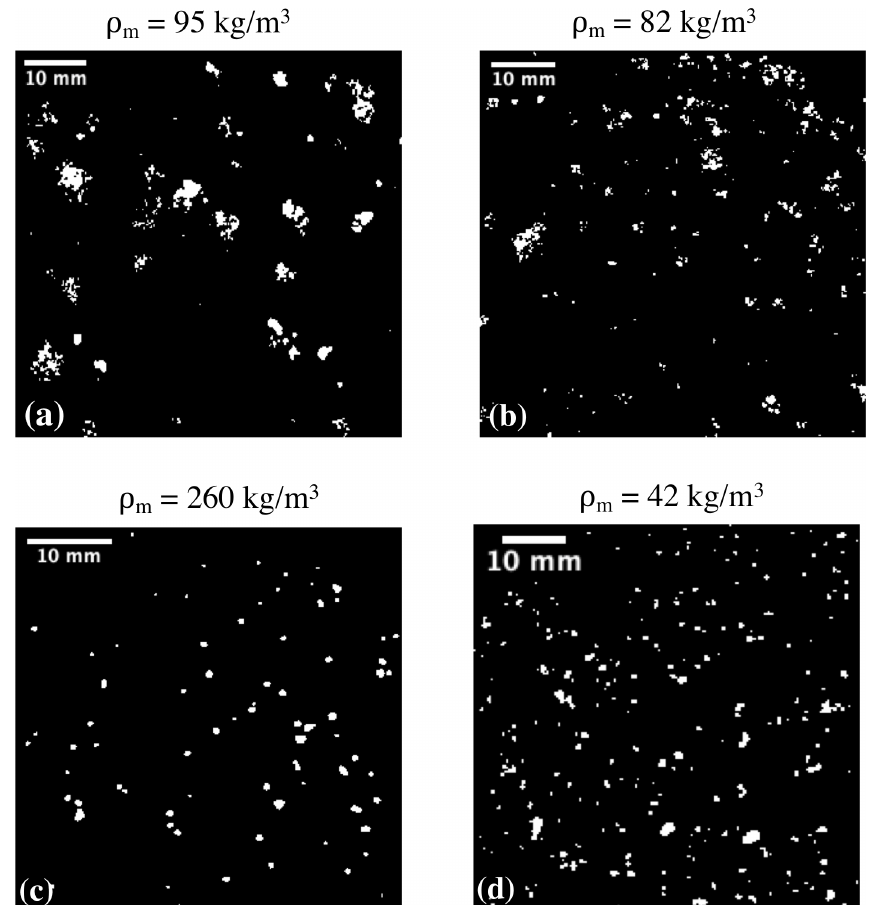
Figure 12. Image of snow particles measured by the DEID at Red Butte Canyon. The mean density values calculated from the mass and effective spherical volume are (a) 95kgm − 3 , (b) 82kgm − 3 , (c) 260kgm − 3 and (d) 42kgm − 3